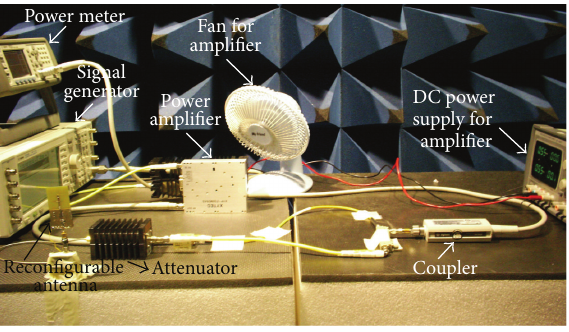
Figure 16: Photograph of the RF-power measurement